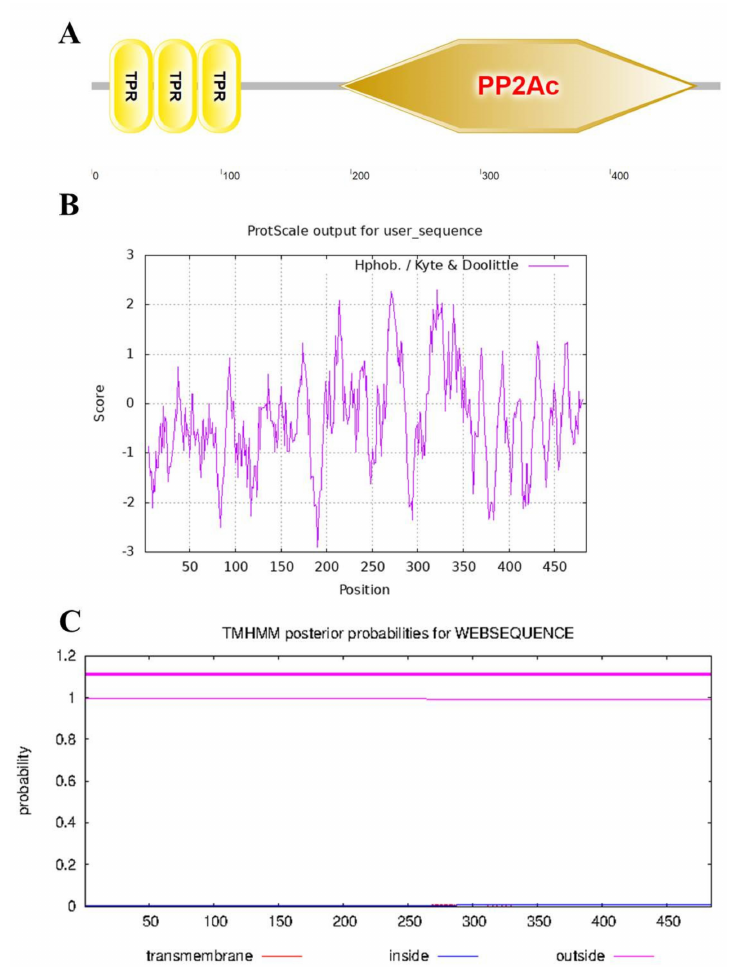
Figure 3. Structural analysis of StPP5: ( A ) structural domain; ( B ) hydrophobicity analysis of StPP5; ( C ) transmembrane domain prediction of StPP5.